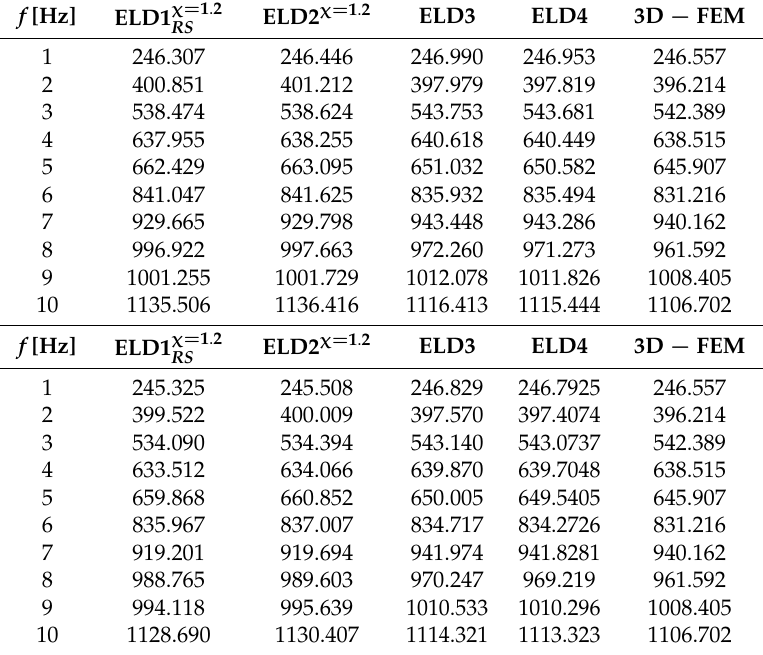
Table 4. First 10 natural frequencies ([Hz]) for a CCCC laminated square plate ( L x = L y = 2m) of thickness h = 0.1m for several higher-order ELW approaches, with and without the Murakami’s function. The Cheb-Gau-Lob grid distribution is used for the numerical solution assuming I N = I M =